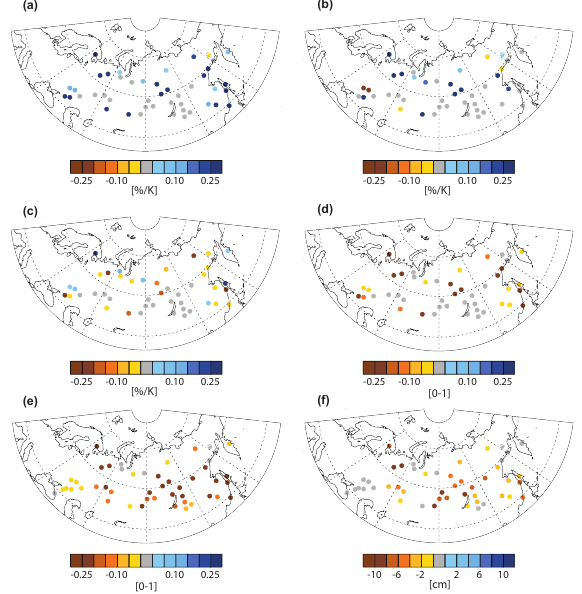
Figure 7. Mean SAF components in anomalies of ERAI-L minus ERAI-LG for 2000–2013 MAMJ: (a) SNC, (b) TEM, (c) snowmelt sensitivity, (d) mean albedo contrast, (e) mean albedo and (f) snow